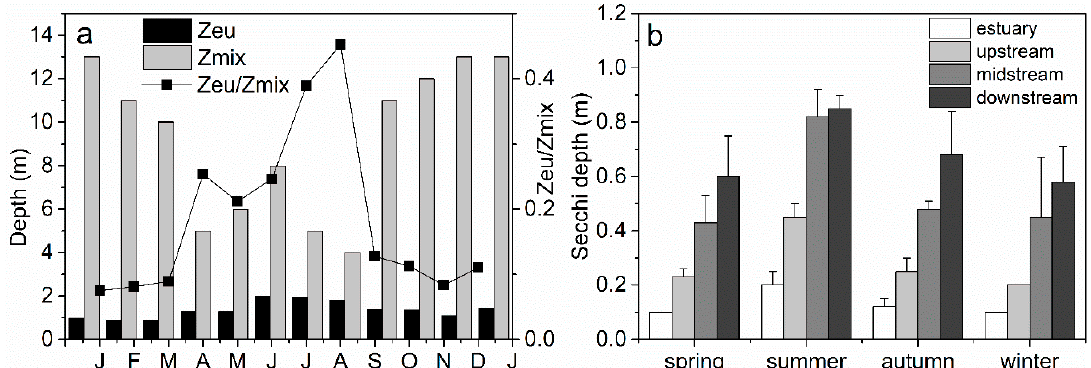
Figure 3. Seasonal variation of Secchi depth ( b ) with standard deviation, Zeu, Zmix and light availability ( a ) for phytoplankton in the Qingcaosha Reservoir.